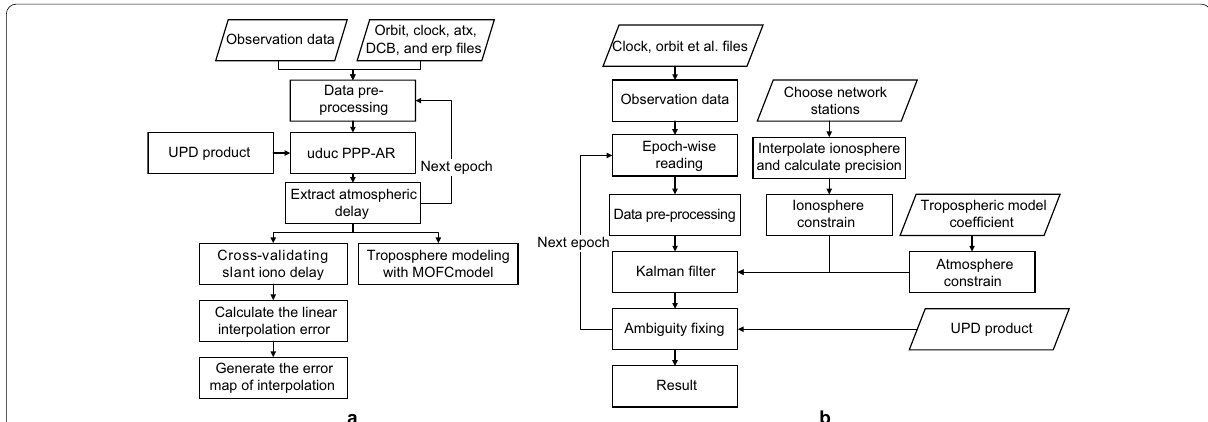
Fig. 1 Flowcharts of the network and the user platforms of the PPP-RTK software and algorithm. The subgraph a is the processing strategies on the server side, and the subgraph b is the processing strategies on the user